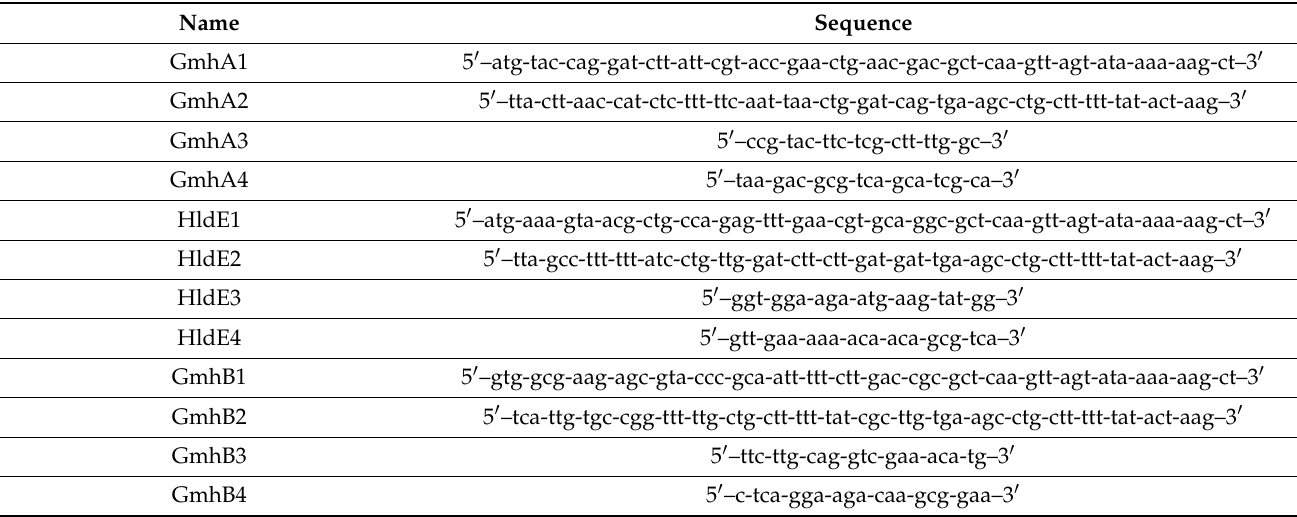
Table 2. Primers for obtaining deletions of LPS biosynthesis